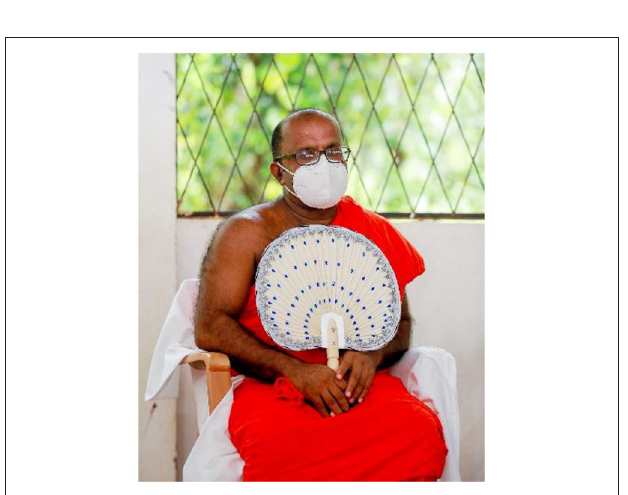
FIGURE 8 | A Buddhist monk during a CAG